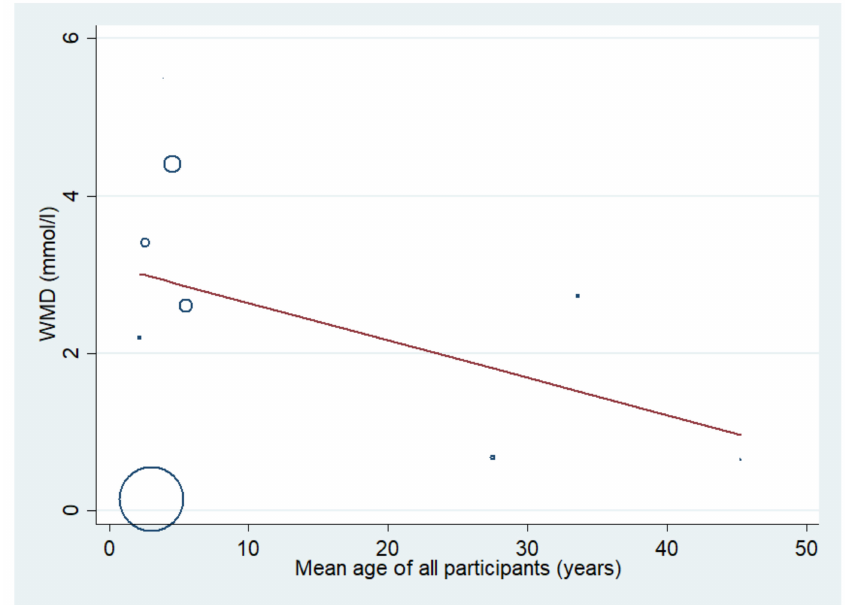
Figure 9. The difference in mean lactate level between patients with severe and uncomplicated malaria using mean age as a covariate. Circles and dots show the WMD of individual studies. Abbreviations: WMD, weighted mean difference; CI, confidence